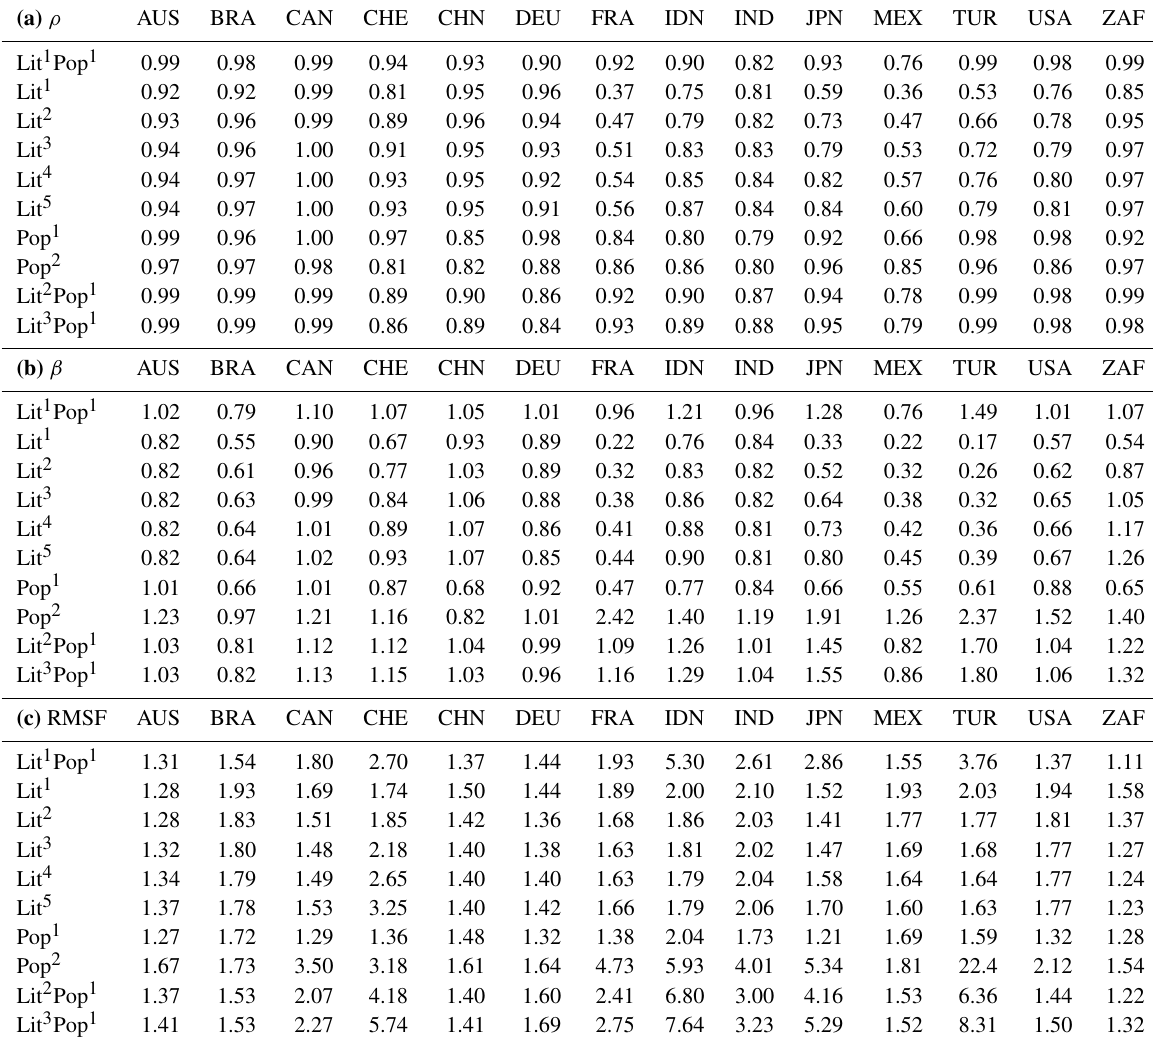
Table A2. (a) Comparison of ρ for 10 exponent combinations and 14 countries: Australia (AUS), Brazil (BRA), Canada (CAN), Switzerland (CHE), China (CHN), Germany (DEU), France (FRA), Indonesia (IDN), India (IND), Japan (JPN), Mexico (MEX), Turkey (TUR), the United States of America (USA), and South Africa (ZAF). Best fit would mean ρ = 1. Linear correlation is statistically significant with a p value lower than 0.05 for all shown countries and combinations. (b) Comparison of β for 10 exponent combinations and 14 countries: Australia (AUS), Brazil (BRA), Canada (CAN), Switzerland (CHE), China (CHN), Germany (DEU), France (FRA), Indonesia (IDN), India (IND), Japan (JPN), Mexico (MEX), Turkey (TUR), the United States of America (USA), and South Africa (ZAF). Best fit would mean β = 1. Linear correlation is statistically significant with a p value lower than 0.05 for all shown countries and combinations. (c) Comparison of RMSF for 10 exponent combinations and 14 countries: Australia (AUS), Brazil (BRA), Canada (CAN), Switzerland (CHE), China (CHN), Germany (DEU), France (FRA), Indonesia (IDN), India (IND), Japan (JPN), Mexico (MEX), Turkey (TUR), the United States of America (USA), and South Africa (ZAF). Best fit would mean RMSF =